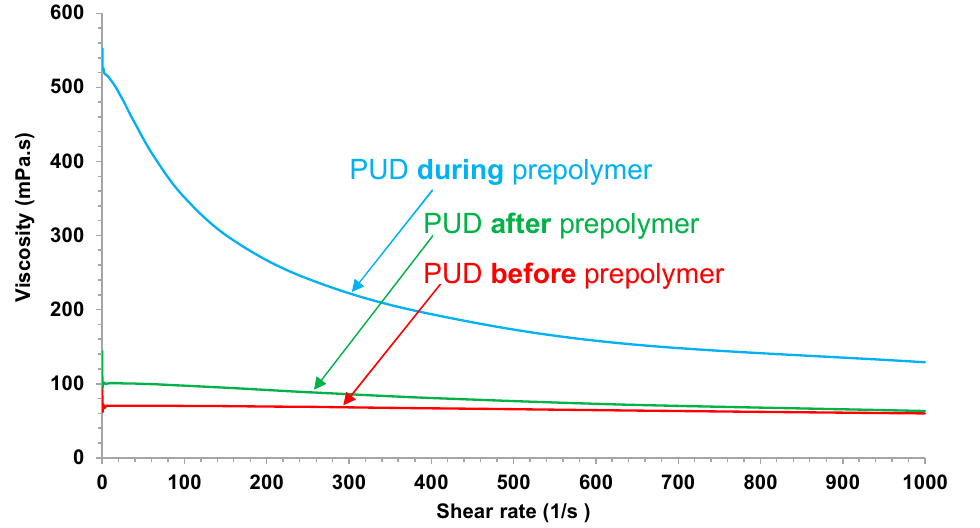
Figure 6. Curve fitting of the particle size distribution curves of the PUDs. Experimental data correspond to the black curves and the curve fitted data correspond to the red curves.